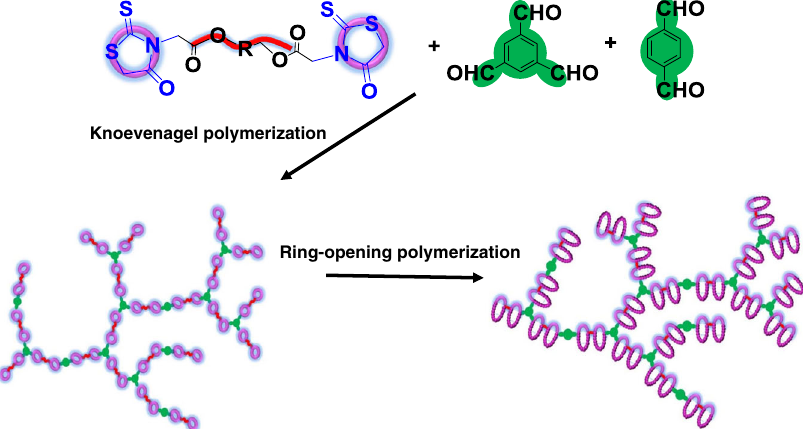
Fig. 7 Schematic illustration of the synthesis of hyperbranched multicyclic polymer. Hyperbranched polyrhodanine is produced by the Knoevenagel polymerization and acts as the ef fi cient macroinitiator to initiate the ring-opening polymerization of thiirane monomers.